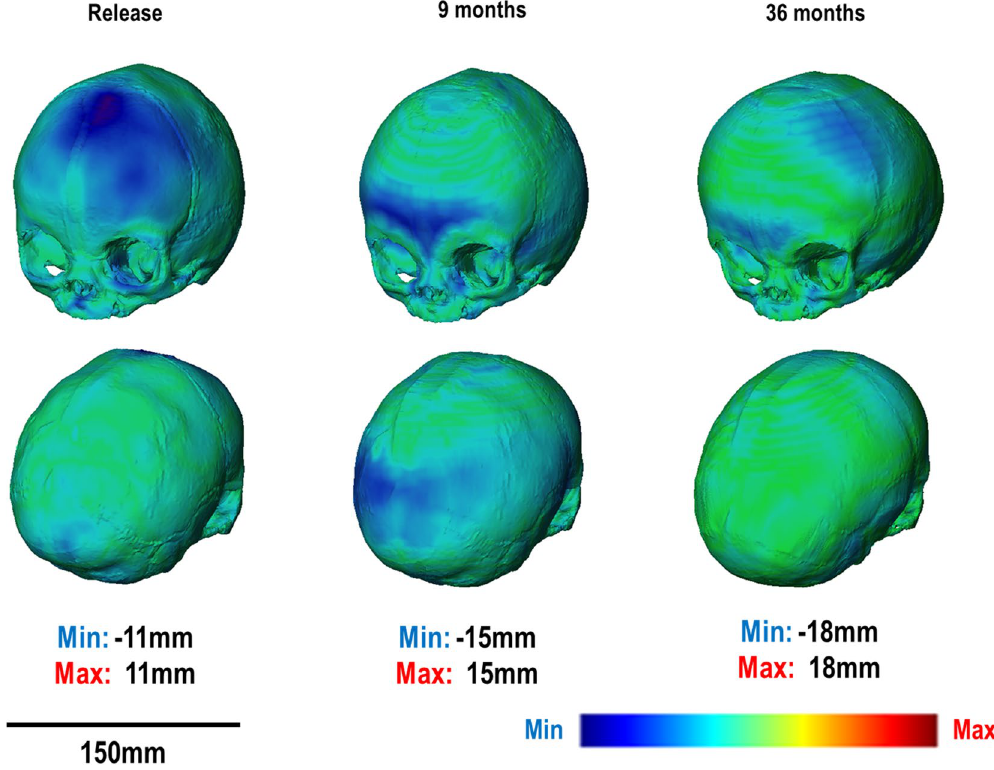
Figure 4. 2 SAC 3D distance plot at respective ages against mean in vivo CT